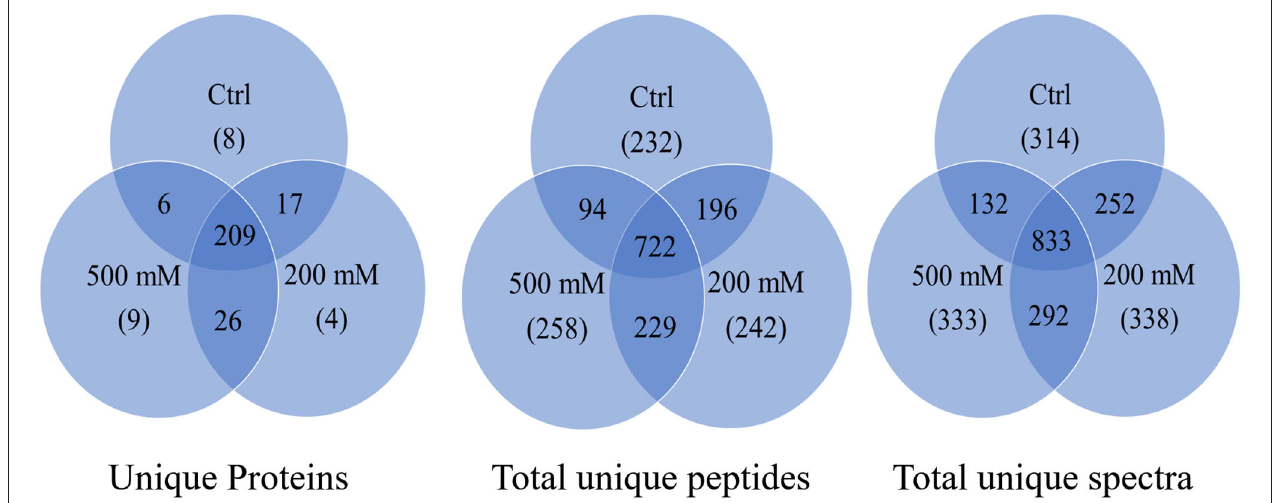
FIGURE 3 | Venn diagram for total proteins, total unique peptides and total unique spectra of Bacillus thuringiensis NEB17 cell-free supernatant proteomics ( n = 3, where every n = a pool of three technical replicate of 100mL culture per treatment).